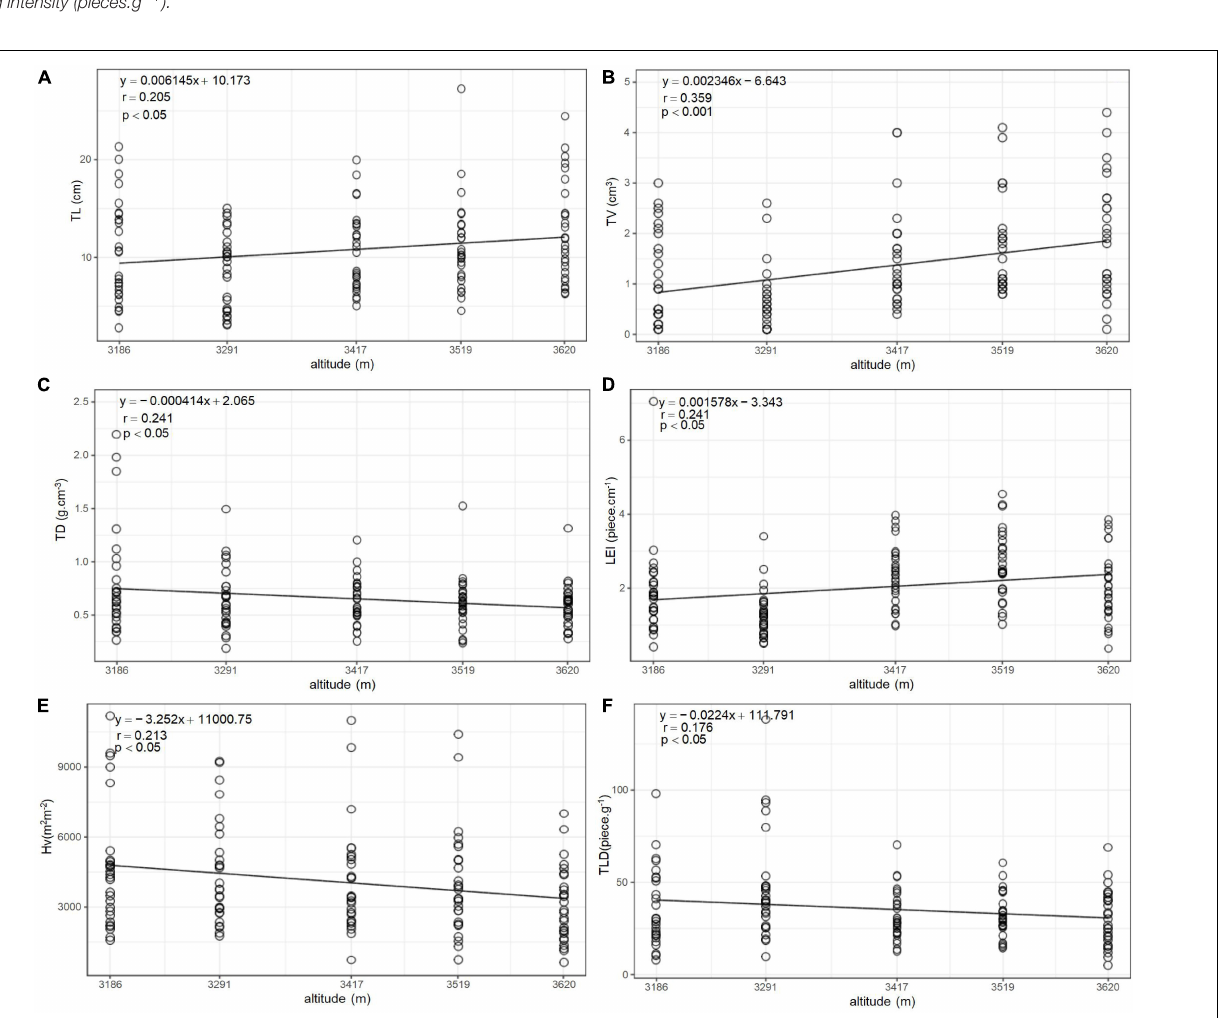
Frontiers in Ecology and Evolution |